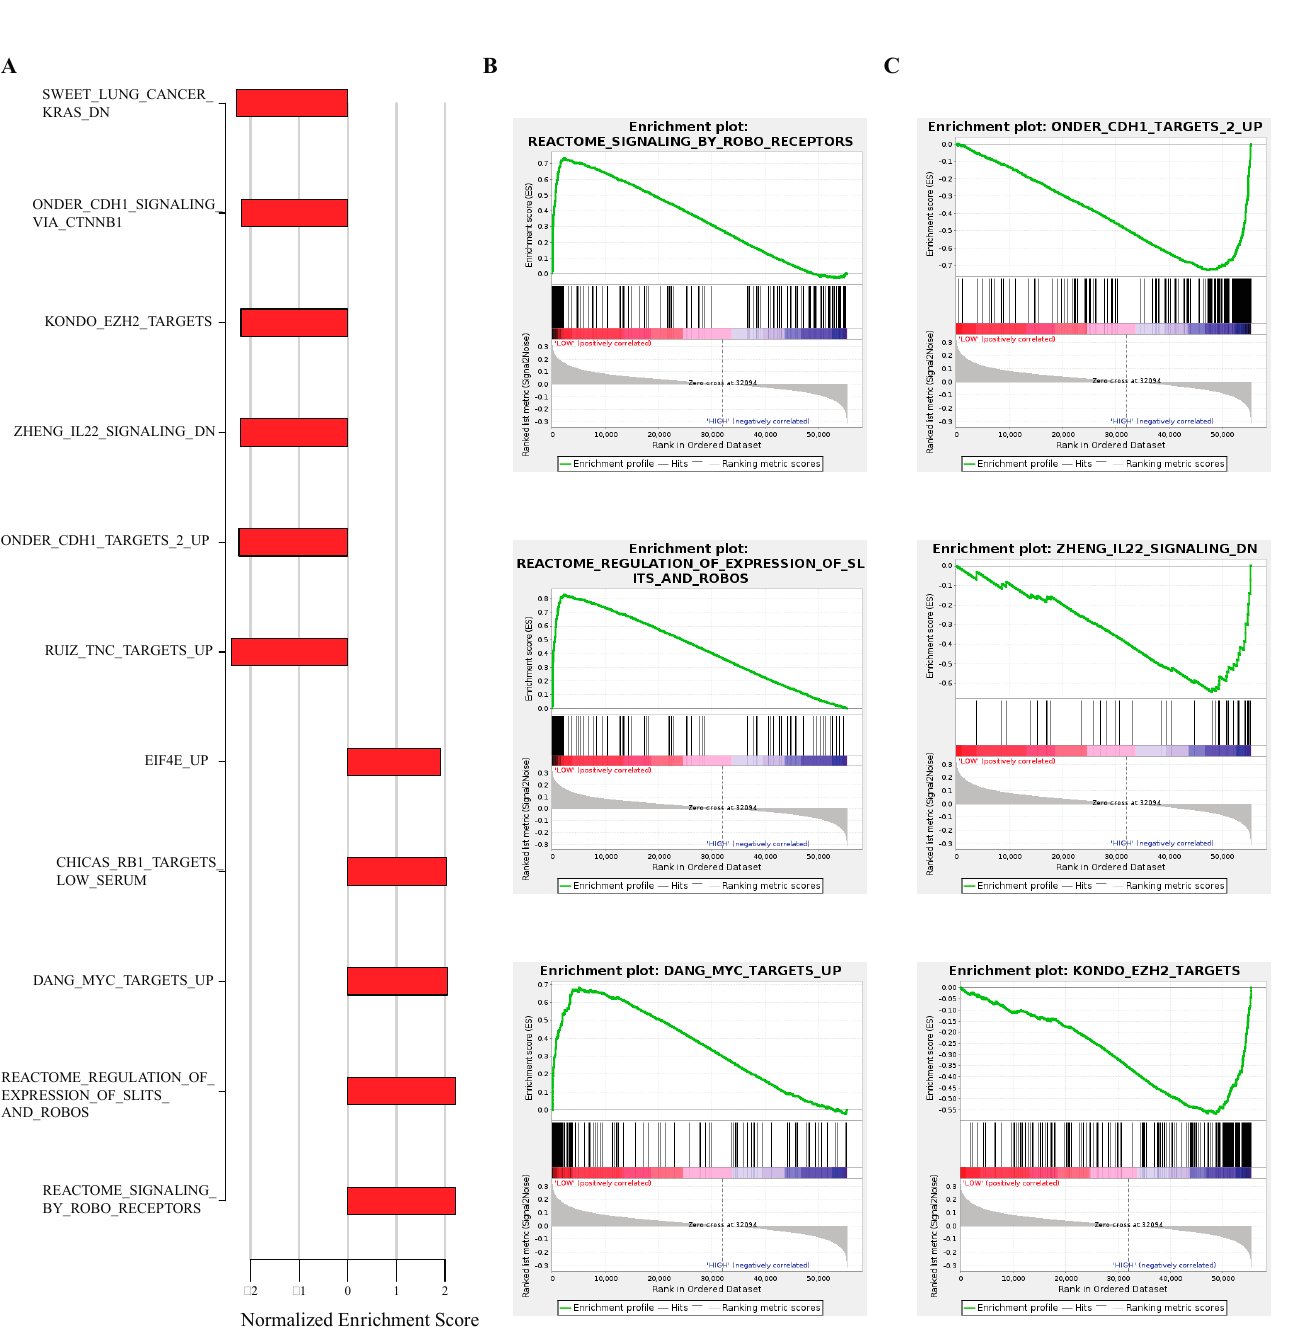
Figure 6. The association between differentially expressed eRNA in HNSCC to cancer and immune pathways using GSEA ( p < 0.05). ( A ) Normalized Enrichment Score (NES) of selected significant pathways. The normalized enrichment score is a measure that represents the extent to which a gene set is overrepresented in the top or bottom of a ranked list of genes that has been normalized across gene sets. ( B ) Enrichment plots showing upregulated pathways. ( C ) Enrichment plots showing downregulated pathways.